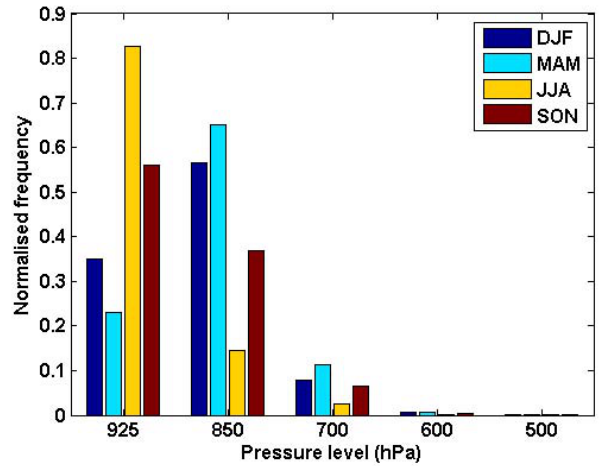
Fig. 6. The normalized histograms of pressure levels at which the peak in WV inversion was observed over 70 ◦ N–90 ◦ N, 180 ◦ W– 180 ◦